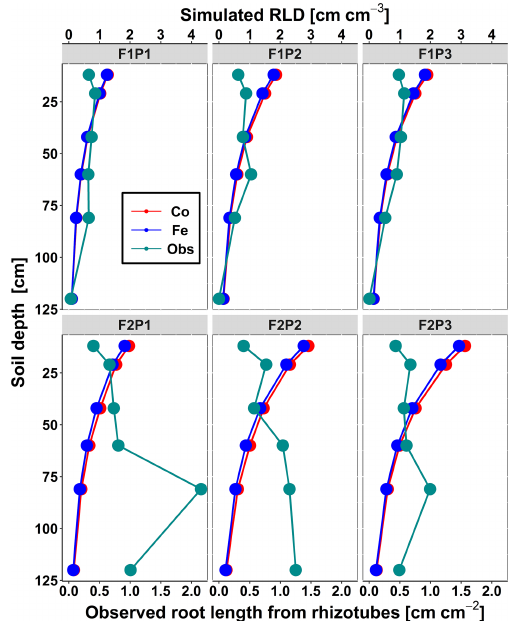
Figure 4. Comparison between observed root length from rhizo- tubes (cmcm − 2 ) (cyan line with dots) and simulated root length density (RLD) (cmcm − 3 ) from 10, 20, 40, 60, 80, and 120cm soil depth at DOY 149 by the Couvreur (Co; solid red) and Fed- des (Fe; solid blue) model in the sheltered (P1), rainfed (P2), and irrigated (P3) plots of the stony soil (F1) and the silty soil